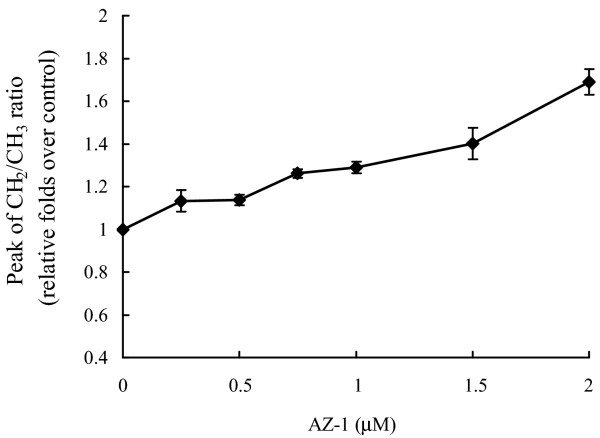
Plot of the ratio of CH2/CH3 peak area according to NMR spectra as the dose of bis-aziridinylnapthoquinone (AZ-1)-treated BC-M1 cells. Cells were seeded for 24 hours before the addition of AZ-1 in various concentrations. The ratio of CH2/CH3 signal intensity was plotted against the various concentrations of AZ-1.